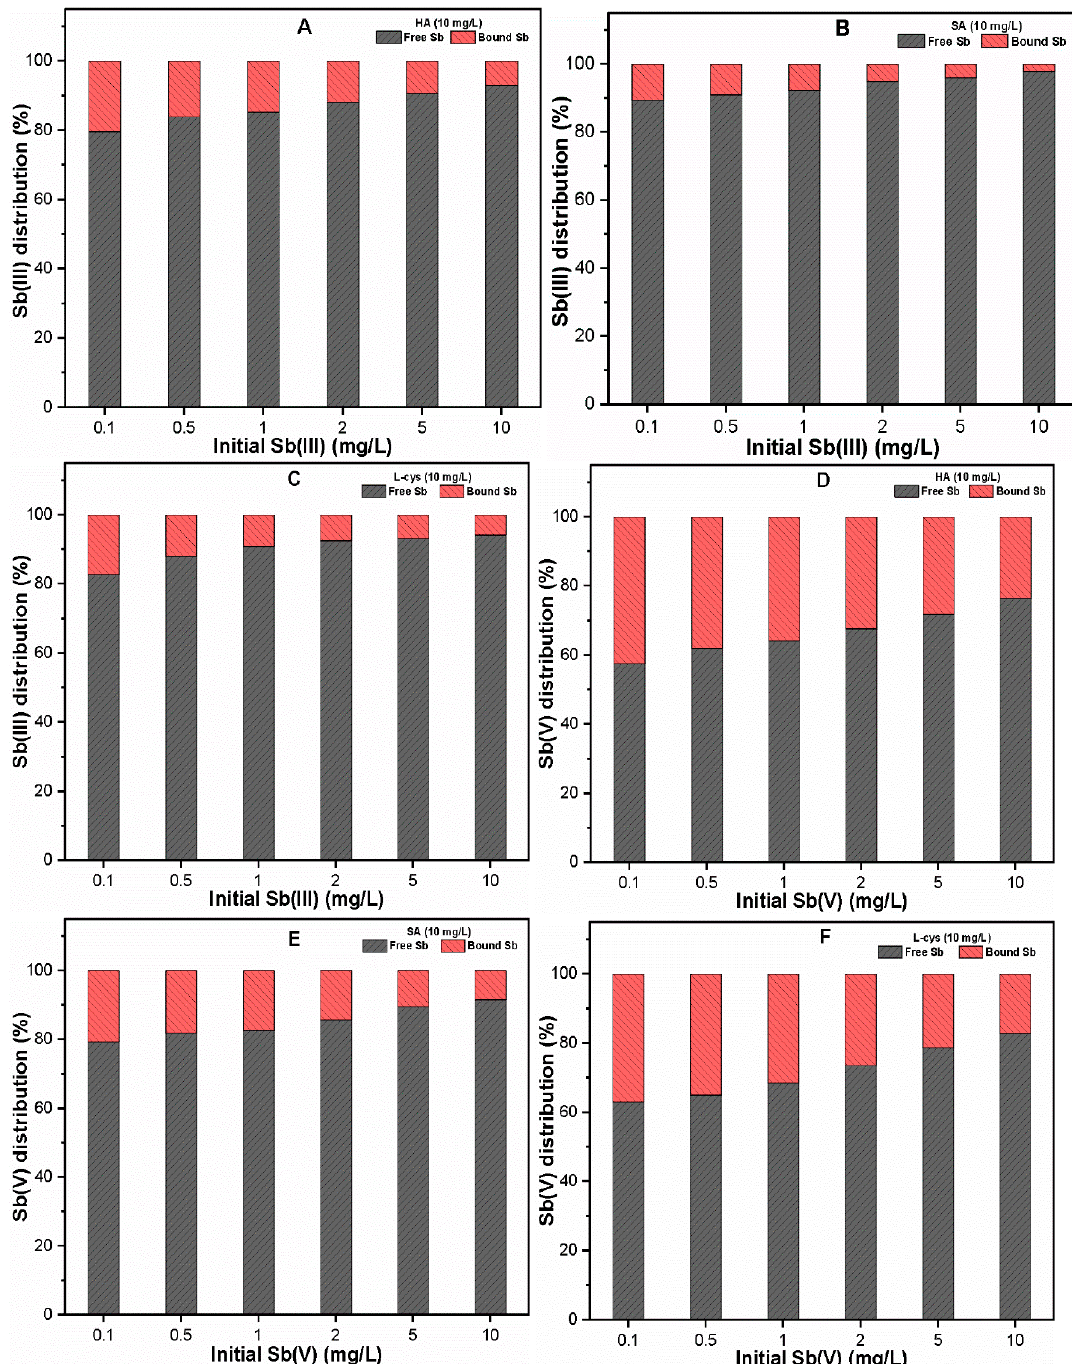
Figure 2. Percent distributions of free and bound (A–C ) Sb(III); and (D–F) Sb(V) in the presence of 10 mg/L NOM.